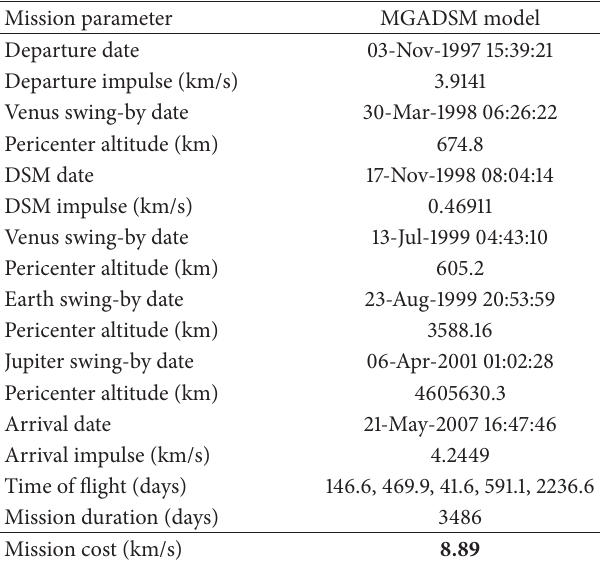
Table 12: MGADSM trajectory of Cassini 2 mission using